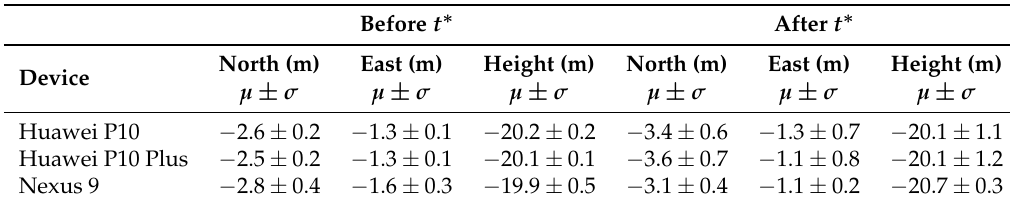
Table 3. Statistics of the smoothed-positioning solutions obtained from smartphones inside the anechoic chamber before and after the event.